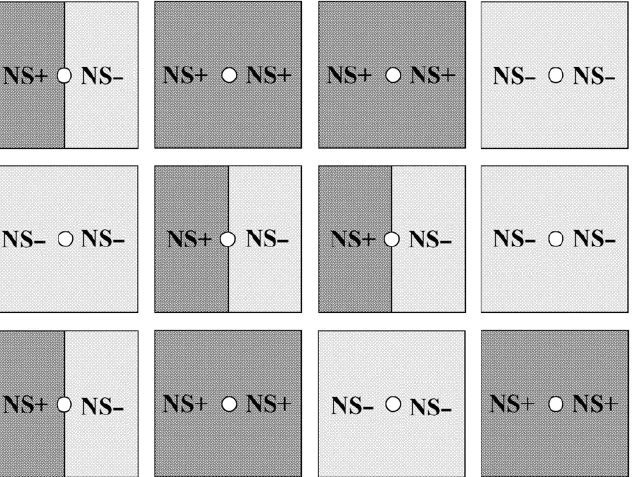
Figure 1. Experimental design. The field trials consist of one homogeneous water-rich treatment (NS+NS+), one homogeneous water-poor treatment (NS − NS − ) and one heterogeneous water treatment (NS+NS−). Each plot was 1.4 m × 1.4 m × 0.5 m in size, filled with nutrient soils, and divided into two patches. For the NS+ patch, saturated irrigation was given once every two days. For NS − patch, saturated irrigation was given once every week. A mother ramet of ‘Arcadia’ Kentucky bluegrass was transplanted in the center of each plot as indicated by the circle. Experiments were conducted in a randomized complete block design, and each treatment was replicated four times.